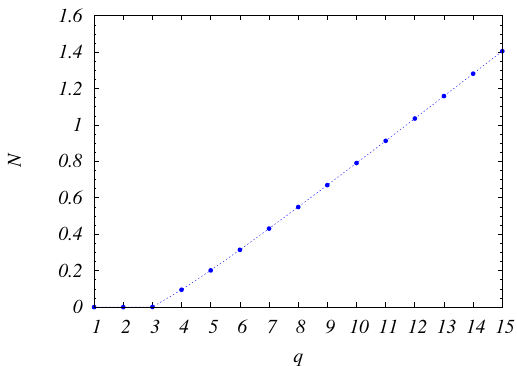
Figure 5: Negativity for two spins at the edges of a Fredkin chain with L = 1000, as a function of the number of colors q